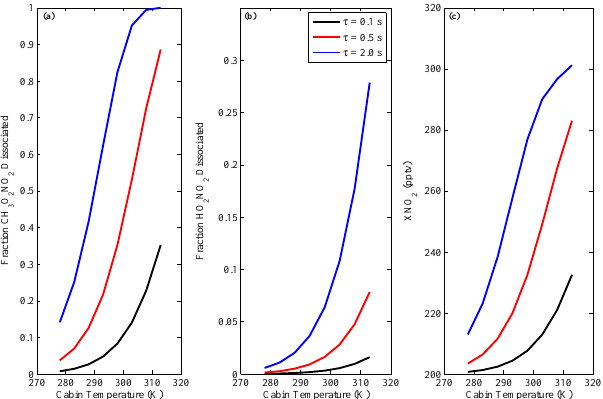
Figure 2. Calculated fraction of (a) CH 3 O 2 NO 2 and (b) HO 2 NO 2 dissociated at residence times of 2.0 (blue), 0.5 (red) and 0.1s (black), and cabin temperatures ranging from 275 to 310K. The calculations are for ambient pressures of 230hPa and ambient tem- peratures of ∼ 225K. (c) XNO 2 (XNO 2 = NO 2 + fraction dissoci- ated CH 3 O 2 NO 2 and fraction dissociated HO 2 NO 2 ) as a function of the residence times and cabin temperatures used in (a) and (b) . We use the median mixing ratios of NO 2 (200pptv), CH 3 O 2 NO 2 (90pptv), and HO 2 NO 2 (40pptv) observed between 220 and 230K during